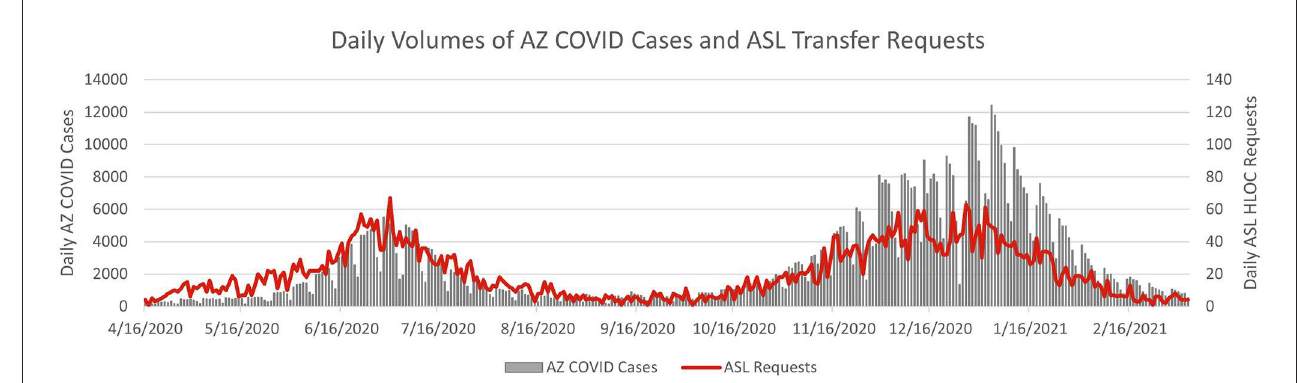
FIGURE1 Daily counts of Arizona COVID-19 cases and ASL transfer requests to a higher level of care. In this graph, the daily volumes of ASL transfers (ASL data) are compared on top of the AZ COVID cases (state data) over the course of the first two COVID-19 surges in Arizona. Transfer requests generally followed the state’s COVID-19 case counts, peaking at 67 requests/day surge Surge 1 and 63 requests/day during Surge